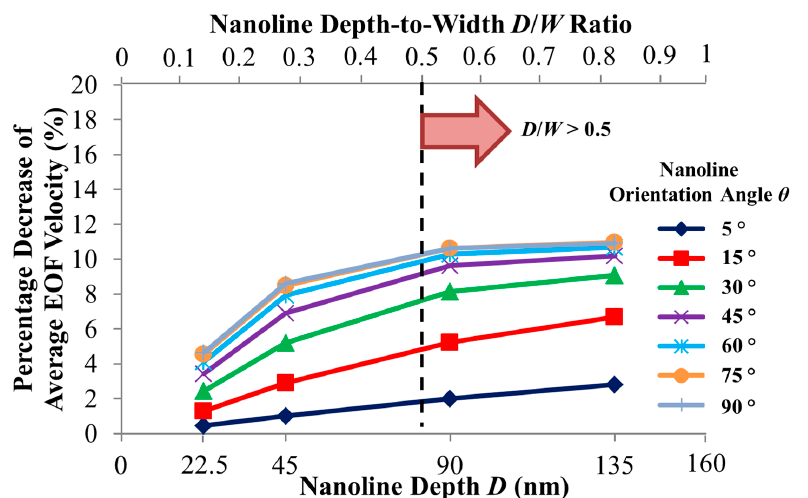
Figure 8. Percentage decrease of simulated average electroosmotic flow (EOF) velocity as a function of nanoline depth D and orientation angle θ , as compared to smooth microchannel. Sodium bicarbonate (NaHCO 3 ) concentration was fixed at 1.0 mM, and nanoline width W and period P were fixed at 160 nm and 400 nm, respectively. Our investigation agrees with Kang and Suh [32] that EOF velocity reduction stabilizes when D / W > 0.5.